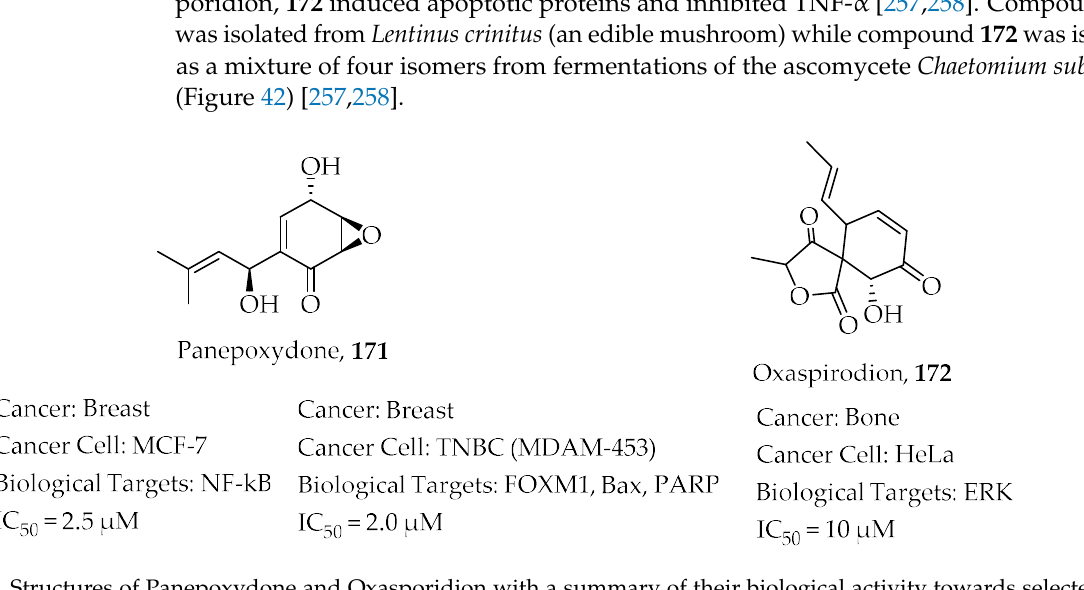
Figure 42. Structures of Panepoxydone and Oxasporidion with a summary of their biological activity towards selected cancer targets.